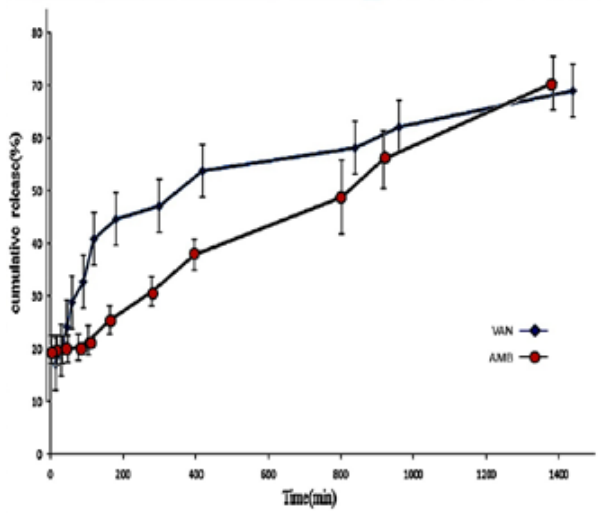
FIGURE 8 - In vitro release profile of VAN and